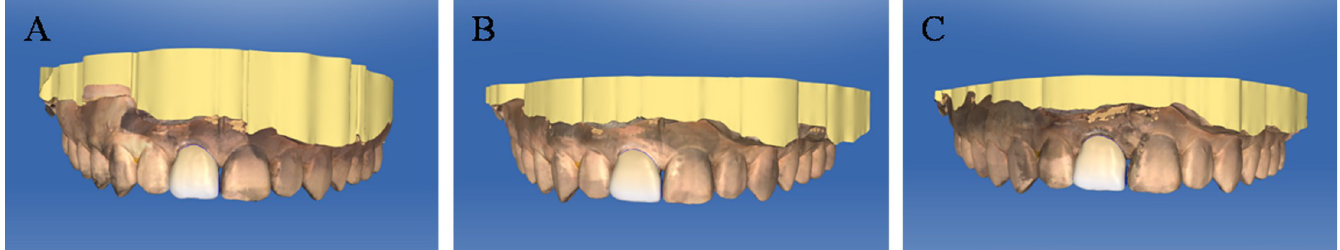
Fig 3. The pictures of the auto-generated crowns by the biogeneric function. (A. BC mode, B. BI mode, C. BR mode).